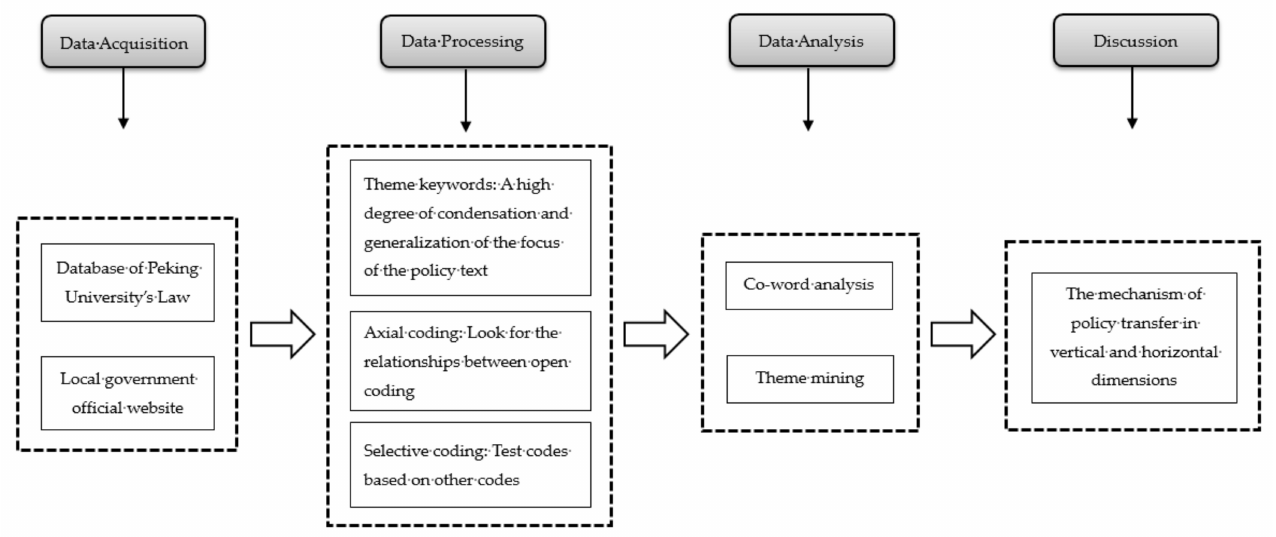
Figure 2. A framework of urban renewal policy research in